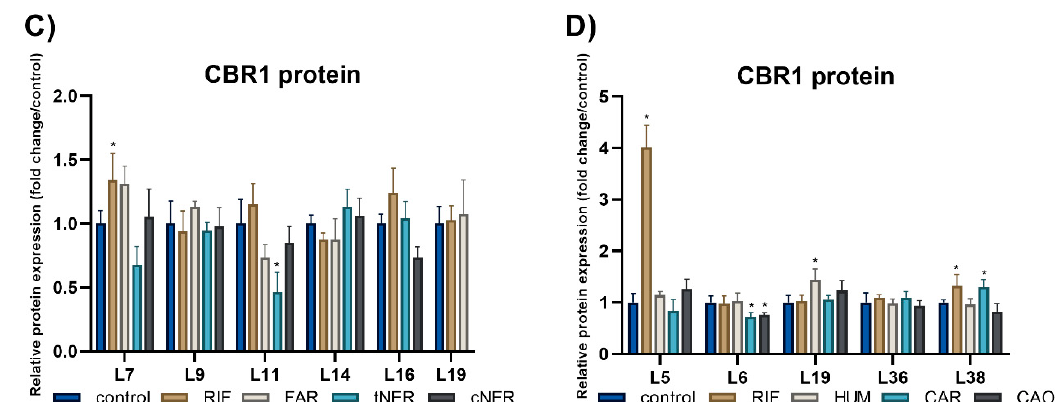
Figure 5. Inter-individual differences in the effect of sesquiterpenes (10 µM) and RIF (10 µM) on the normalized protein expression of CYP3A4 ( A , B ) and CBR1 ( C , D ) in human PCLS from ten patients after 24 h ( n = 3). The protein expression was calculated using calnexin as a loading control. Results are presented as the mean ± SD ( n = 4), with controls set to 100%. Statistical analyses were performed using one-way ANOVA with Dunnett’s test: p < 0.05 (*).